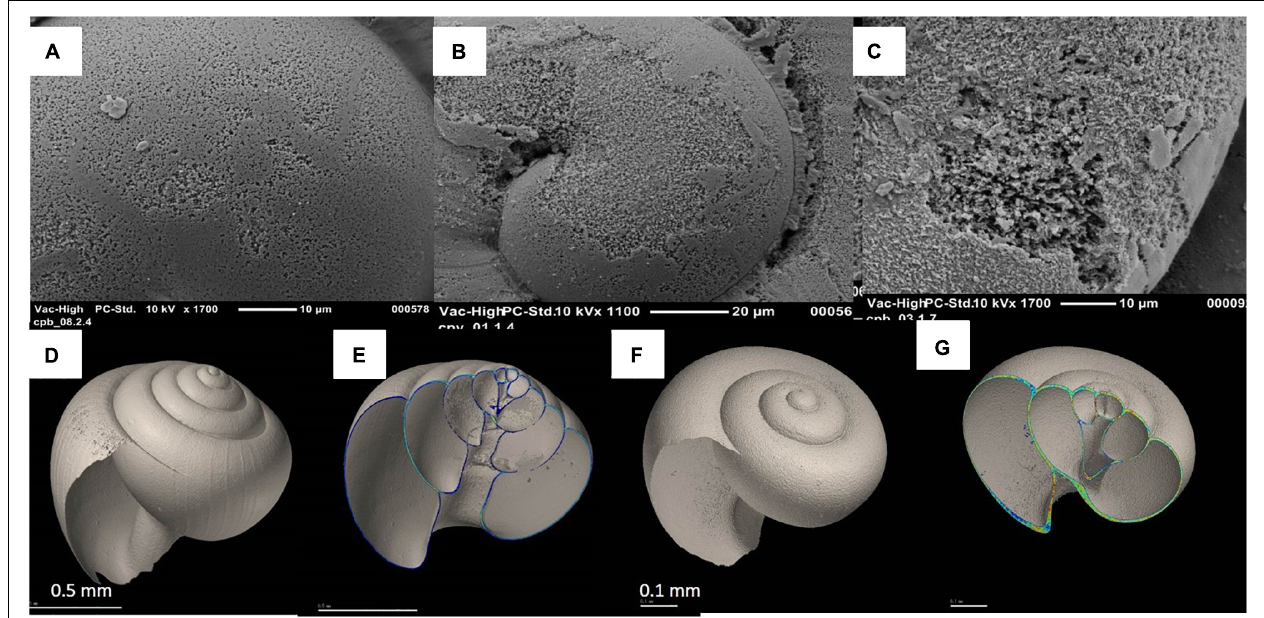
FIGURE 2 | Various degrees of pteropod shell dissolution from the GoA and the Bering Sea, progressing from increased porosity, moderate to the most severe dissolution; Type I (A,B) , Type II (B,C) , and Type III (C) . Two different Morphotypes of Limacina helicina : Limacina h. helicina (D) and Limacina h. pacifica (F) with respective images of their shell thickness for Limacina h. helicina (E) and for Limacina h. pacifica (G) . Color bar indicates the CT number as a shell density from 380 (lowest density) to 1000 (highest